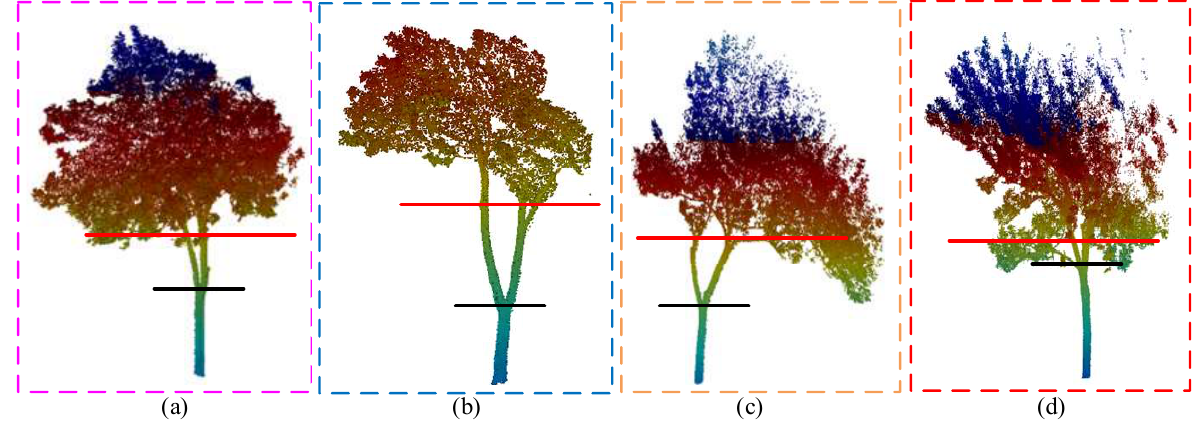
Figure 19. Incomplete segmentation cases: The red solid line indicates the correct segmentation position. The black solid line indicates the proposed method segmentation position. ( a ) Figure 13d; ( b ) Figure 13e; ( c ) Figure 13f; ( d ) Figure 13g.